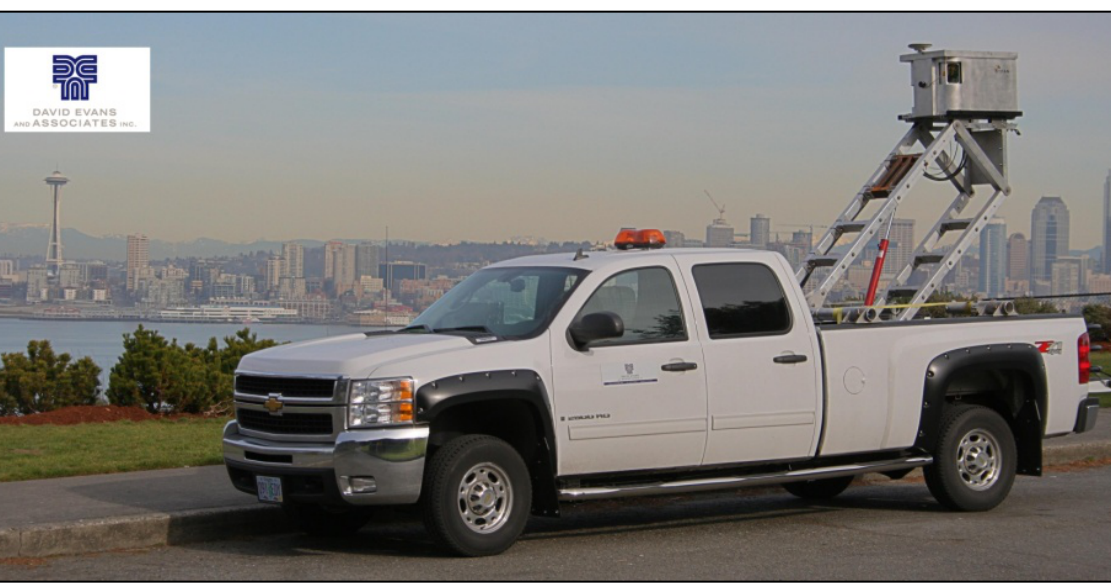
Figure 1. Example of a mobile laser scanning (MLS) system (TITAN, courtesy of